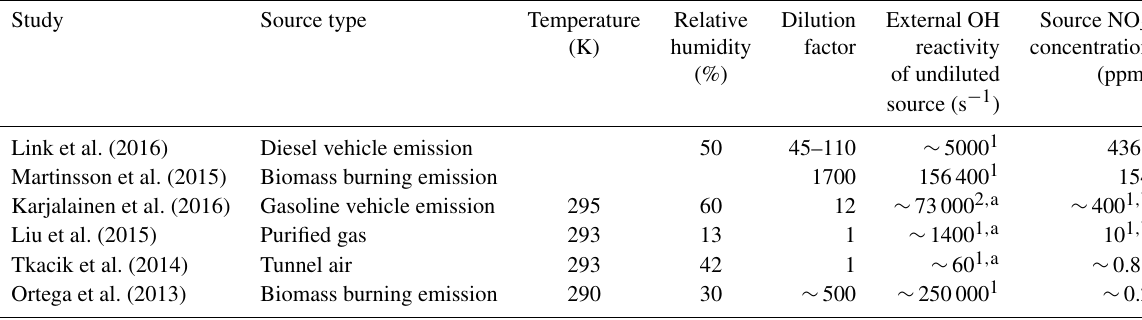
(K) humidity factor reactivity concentration (%) of undiluted (ppm) source (s − 1 )